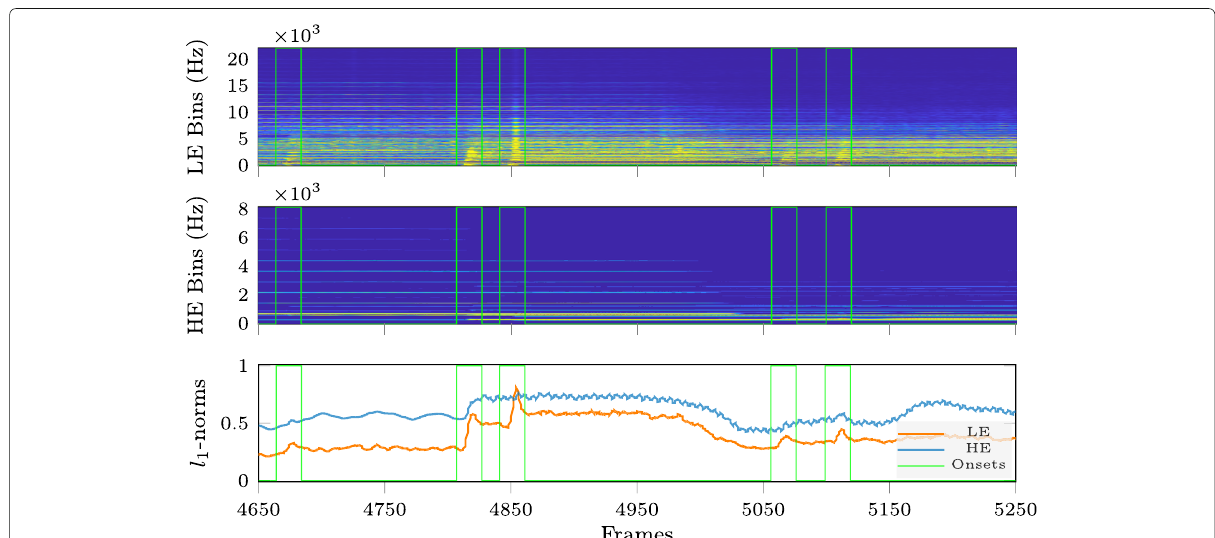
Fig. 4 Temporal variation of signal energy per frequency bin and of spectral sparsity for trumpet (Bach) excerpt. Note onsets are indicated by vertical lines. (Top and middle) Low- and high-energy log-magnitude spectrograms. (Bottom) Low- and high-energy STFT log-magnitude coefficient vector (cid:4) 1 -norm variation